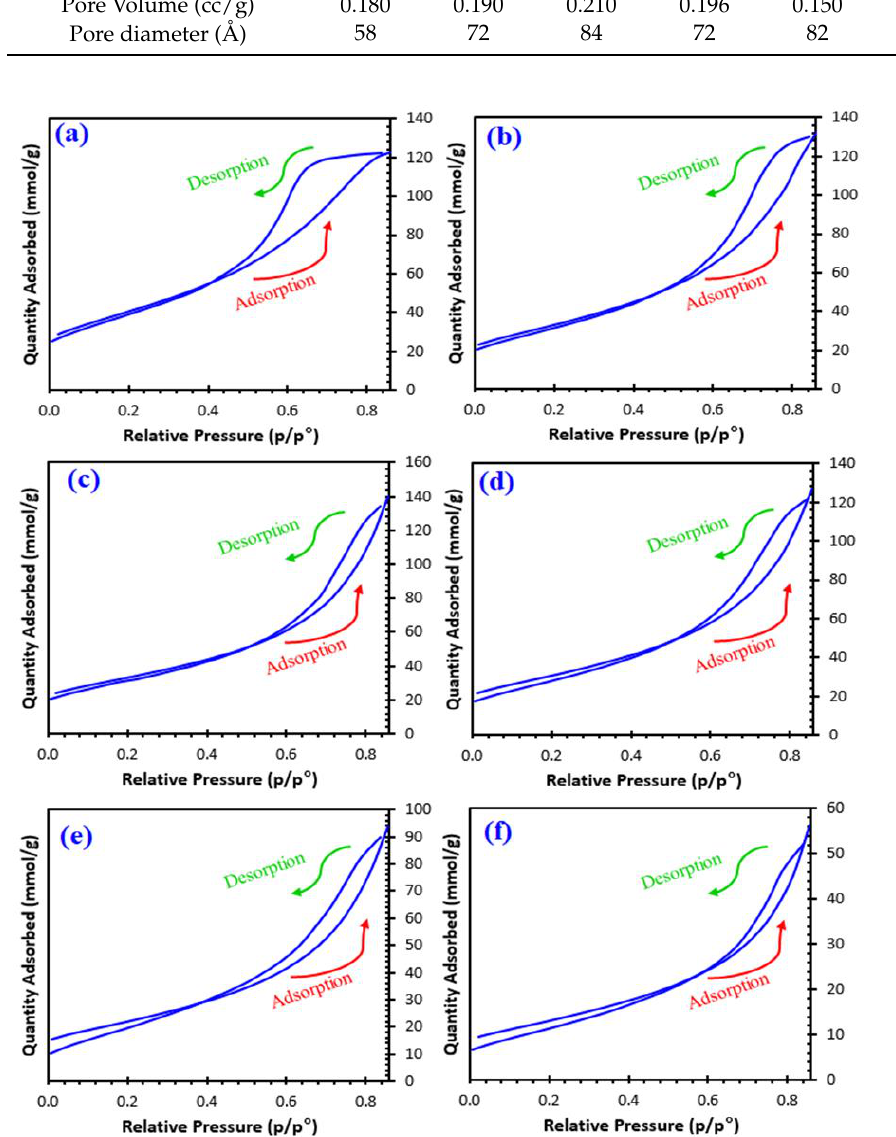
Figure 4. Nitrogen physisorption isotherm plots of; ( a ) x0, ( b ) x01, ( c ) x02, ( d ) x03, ( e ) x04, and ( f ) x05.